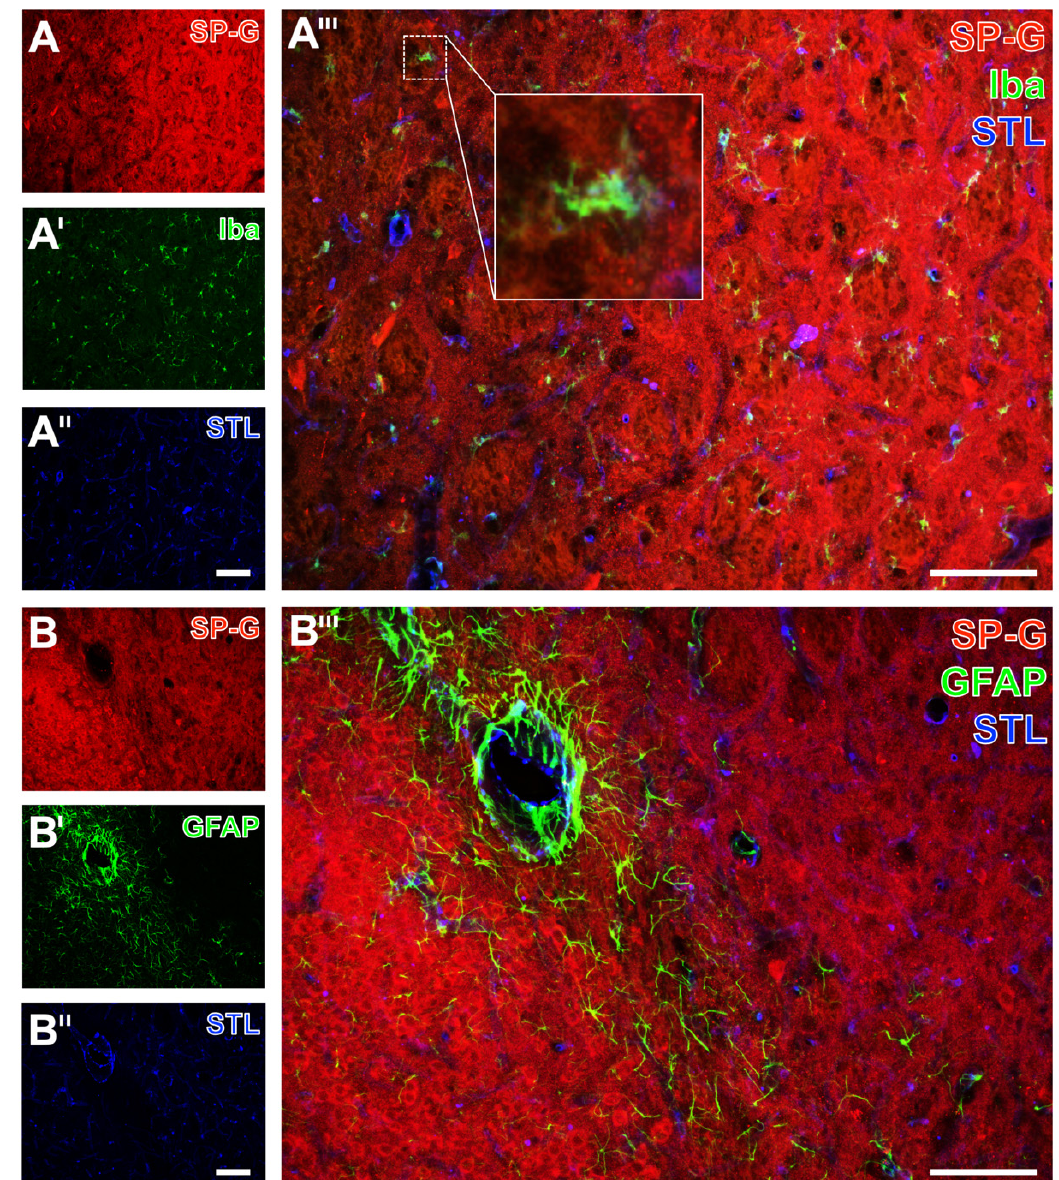
Figure 10. Regional associations of surfactant protein-G (SP-G), vascular and glial elements after focal cerebral ischemia in the striatum of rats. Triple fluorescence labeling of SP-G, ionized calcium- binding adapter molecule-1 (Iba) for microglia and vascular STL-binding sites in a rat 24 h after focal cerebral ischemia ( A – A’’’ ). Immunolabeling of SP-G and astroglial GFAP combined with vas- cular STL-staining ( B – B’’’ ). Scale bars: A’’ (also valid for A and A’ ) = 100 μ m, A’’’ = 100 μ m, B’’ (also valid for B and B’ ) = 100 μ m, B’’’ = 100 μ m.